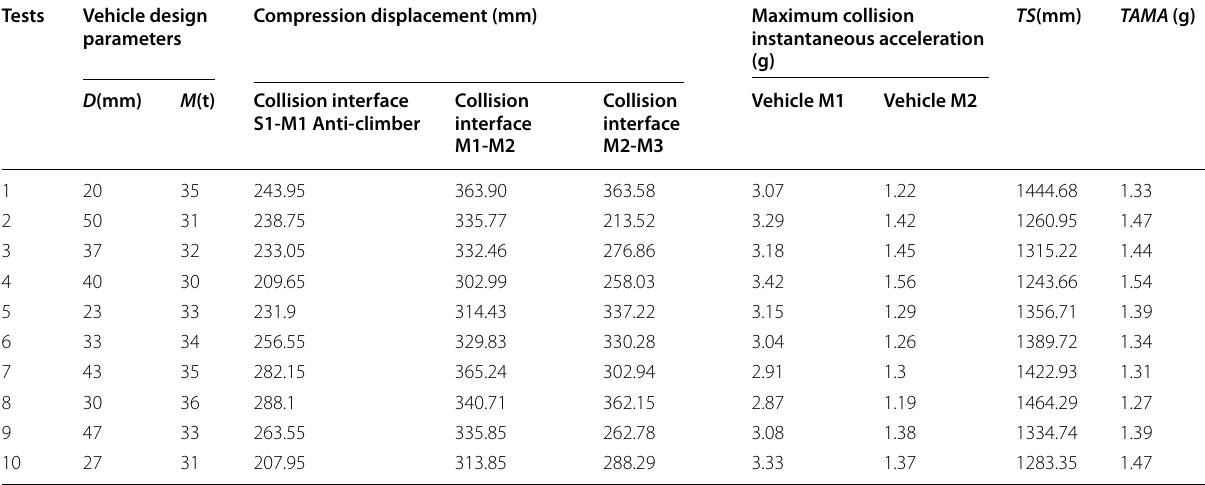
Table 9 Train collision response matrix Tests Vehicle design parameters